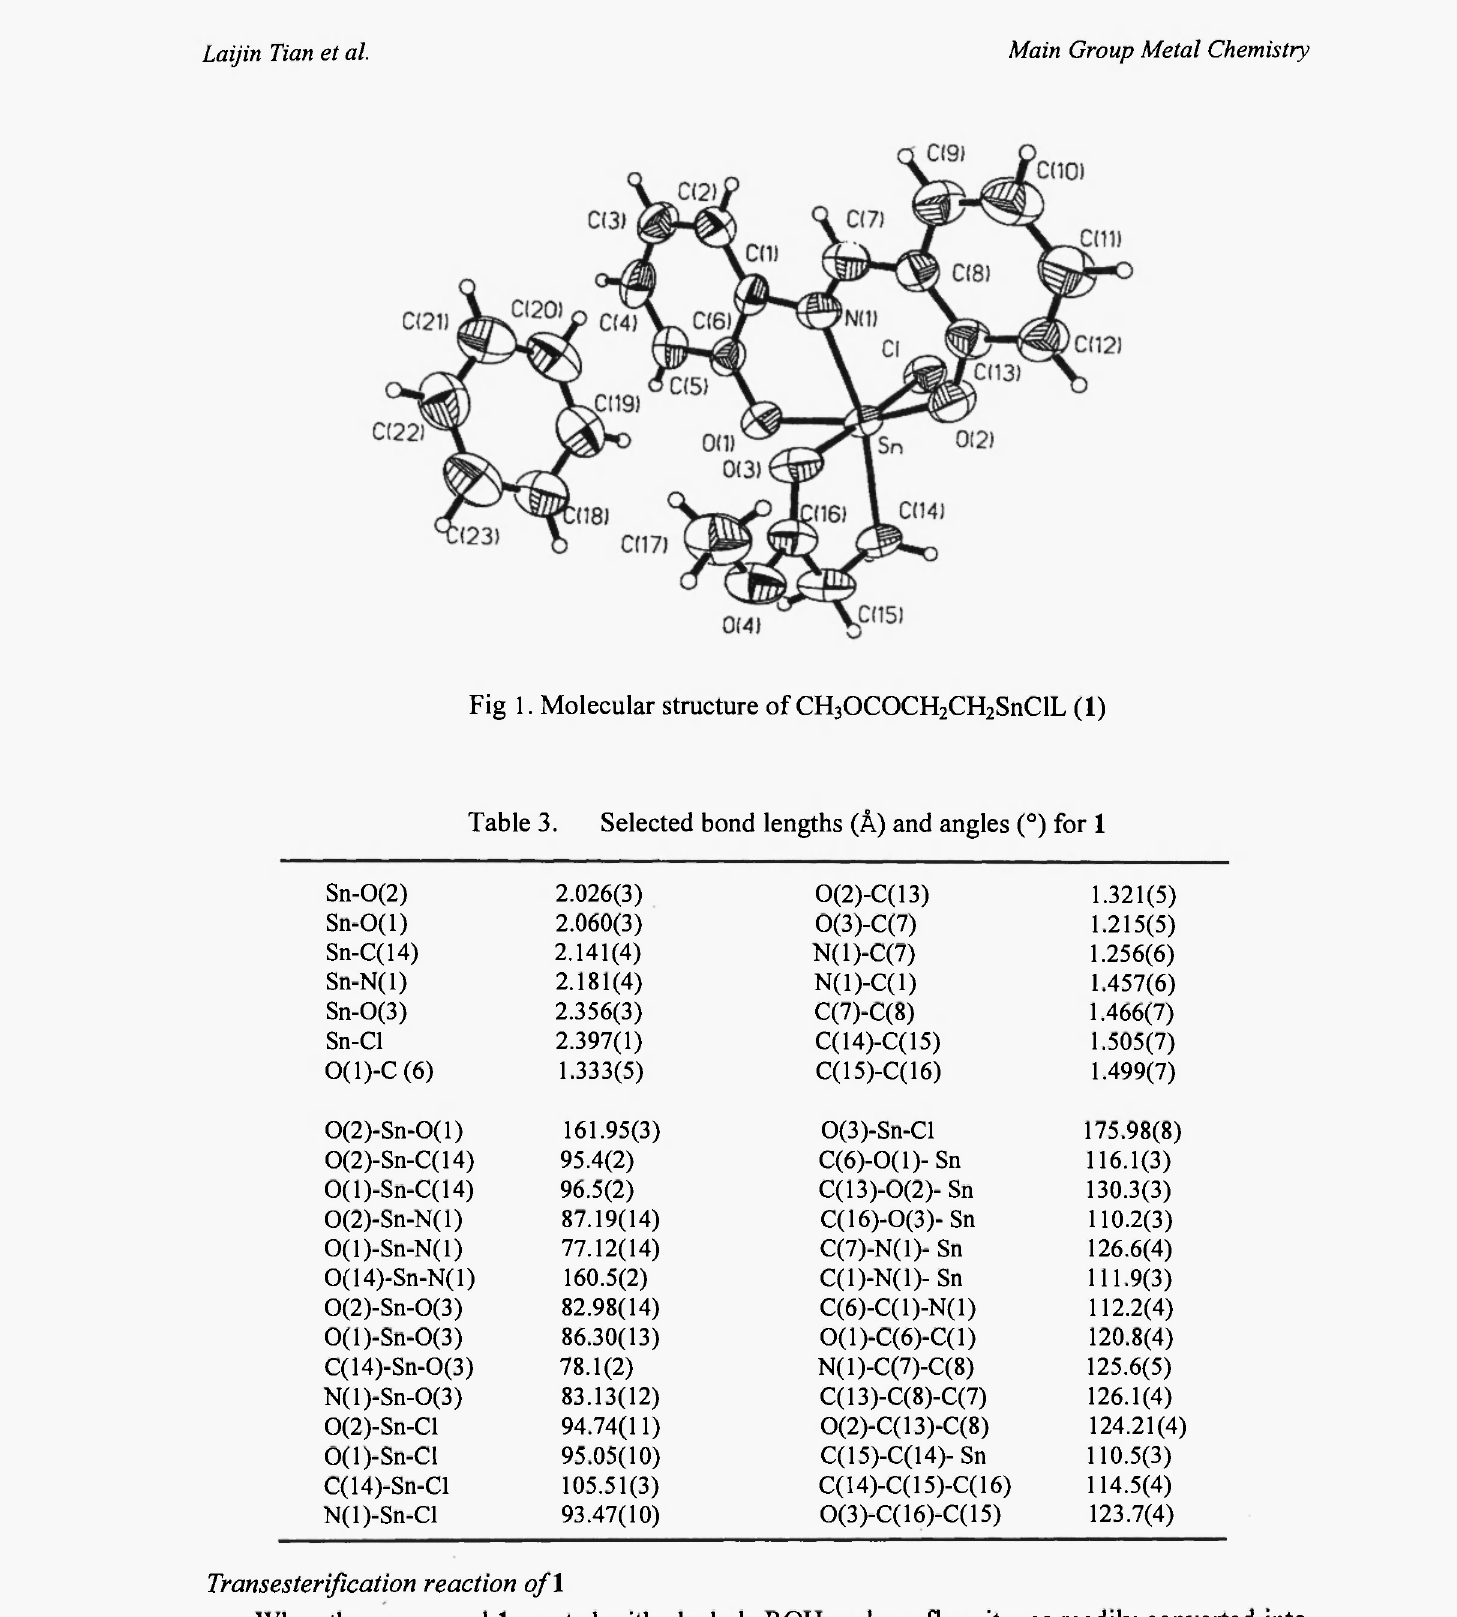
Fig 1. Molecular structure of CH